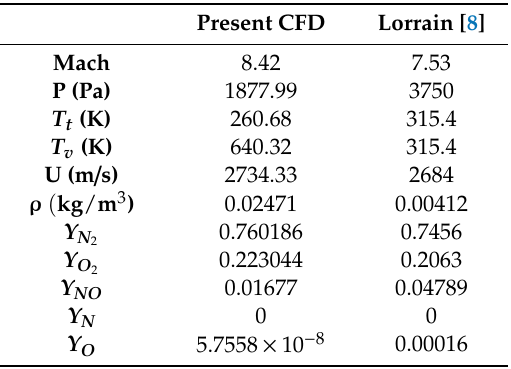
Table 2. Flow properties at the nozzle, used for inflow conditions of the model